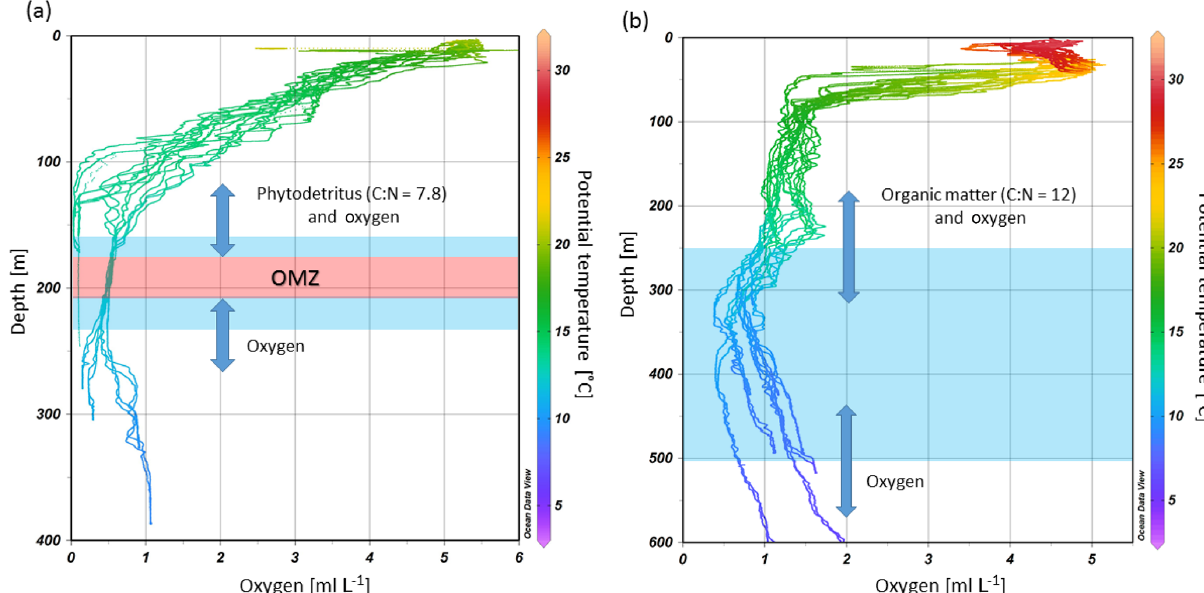
Figure 9. Depth range of cold-water coral mound occurrences (blue shaded areas) at the (a) Namibian and (b) Angolan margins in relation to the dissolved oxygen concentrations and potential temperature. Diurnal tides are delivering mainly phytodetritus (shown in a ) and organic matter from the benthic nepheloid layer (shown in b ) as well as oxygen from above and from below to the mound sites (indicated by blue arrows, the lengths of which indicate the tidal